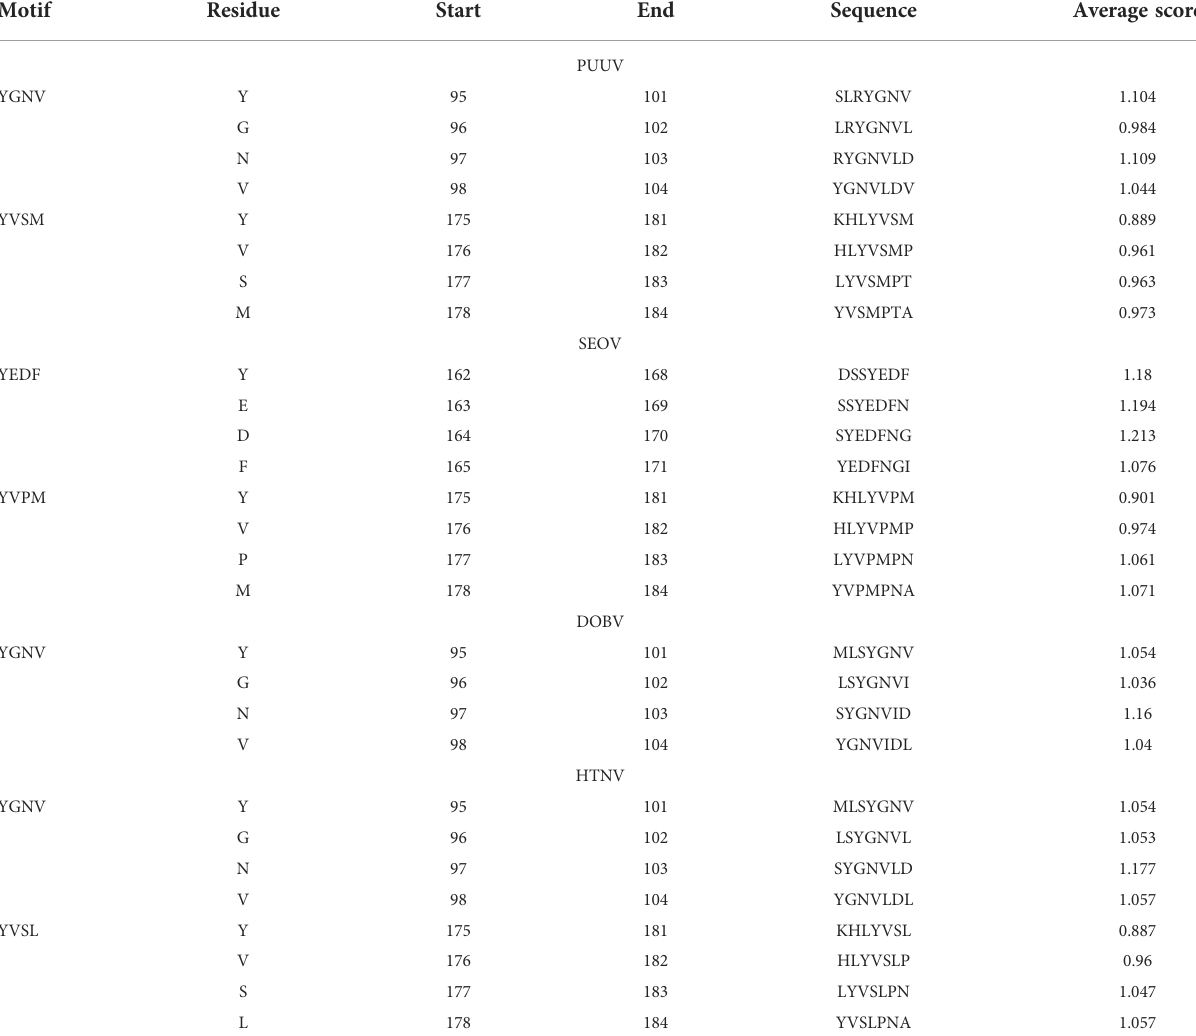
TABLE 3 Enlist immune epitopes within YXX F [I/L/M/F/V] motifs.